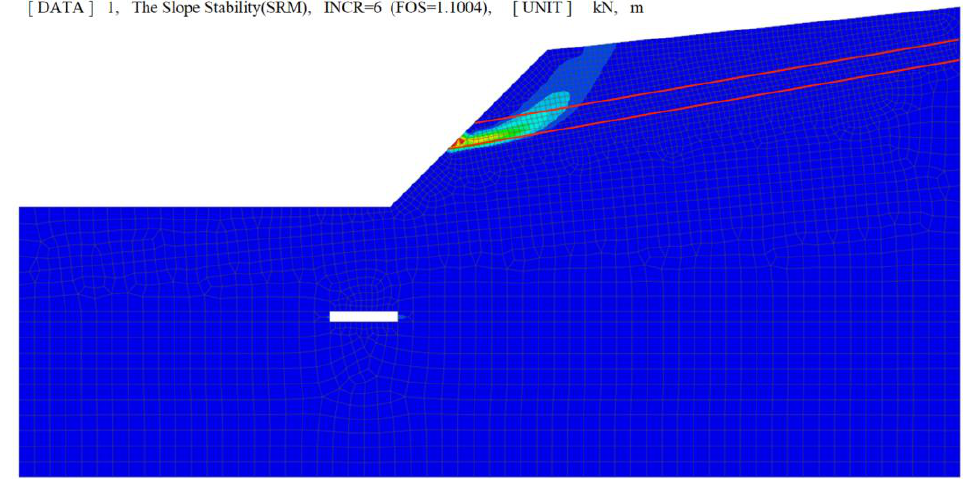
Figure 5. Calculation stability of the slope containing a coal seam in a goaf. Within the scope of the red line is the position of the coal seam.